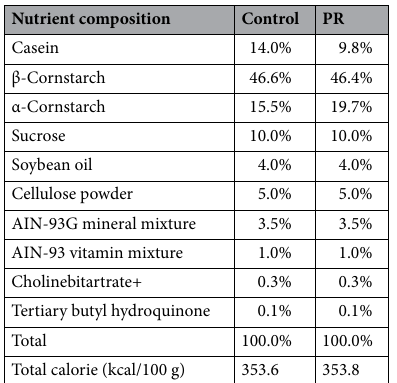
Table 1. Nutrient composition of the diet fed to the protein-restricted mice. Control mice were fed with a diet of 353.6 kcal/100 g. Protein-restricted (PR) mice were fed with a diet of 353.8 kcal/100 g containing a 30% reduction in casein from AIN-93M, which was replaced with a cornstarch